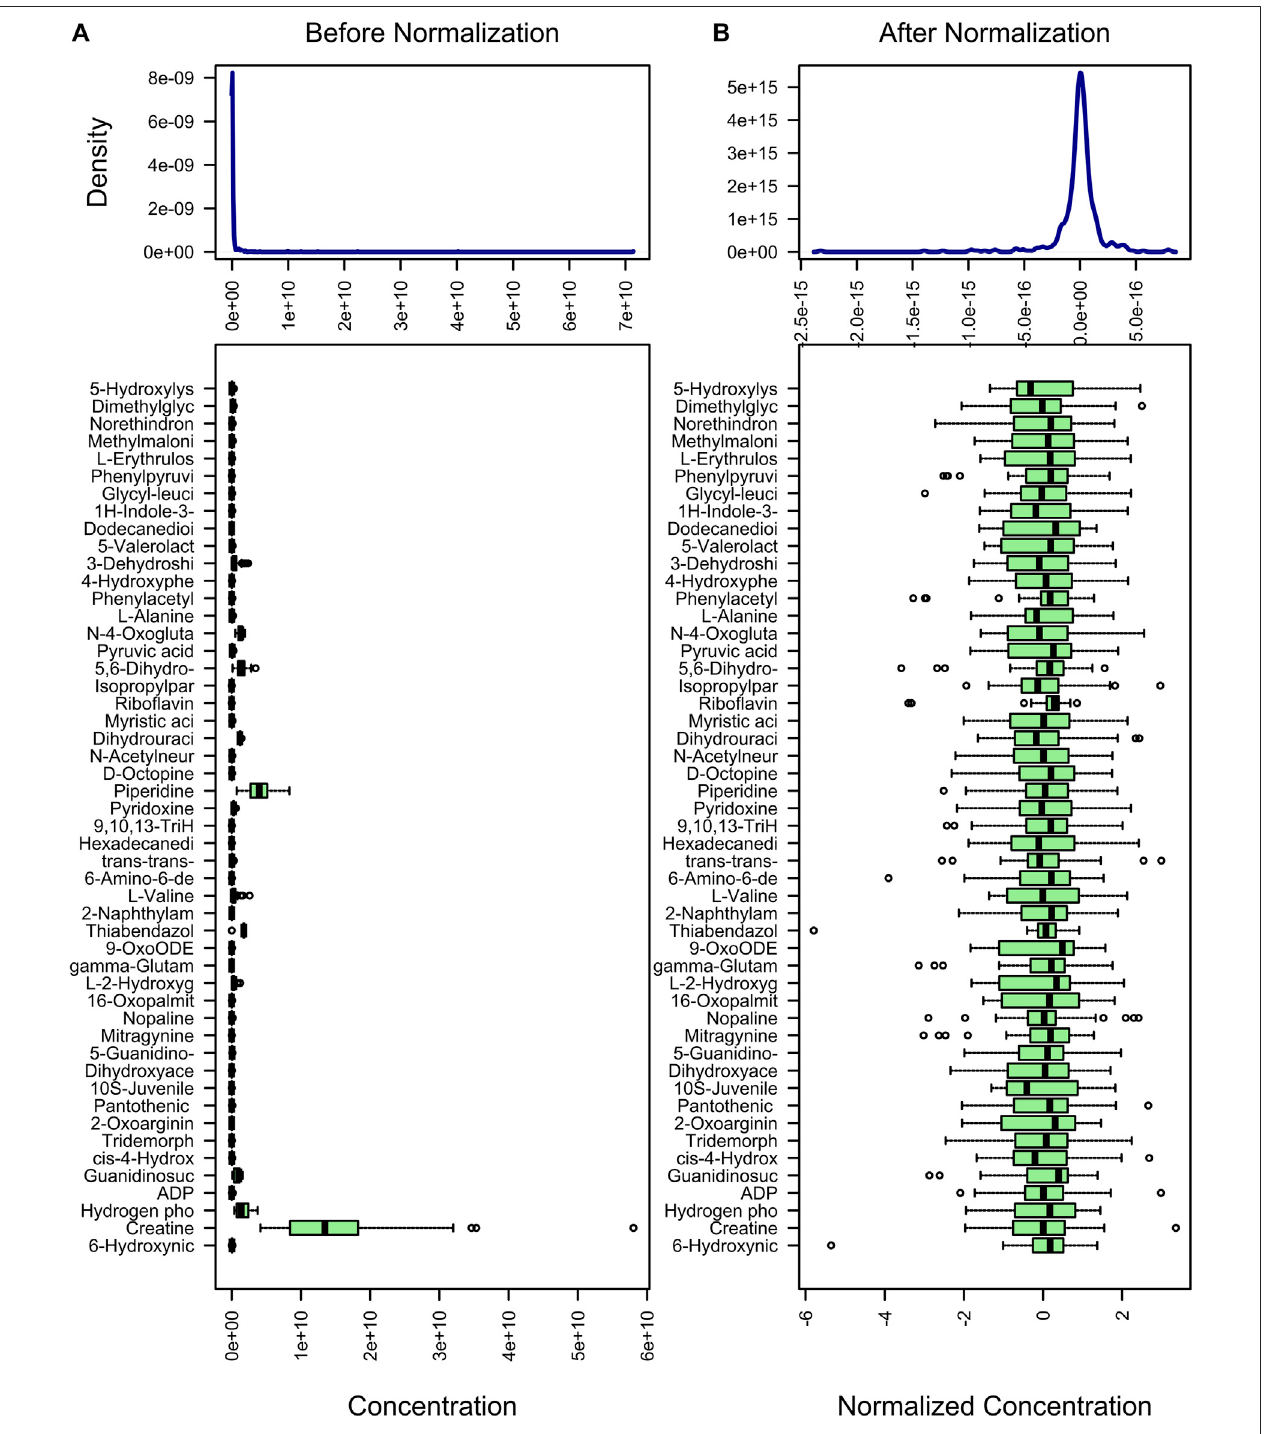
FIGURE 2 | Standardization of metabolites. The content distribution is represented by a box plot, which corresponds to outliers, minimum, lower quartile, median, upper quartile, maximum, and outliers from left to right. The picture on the left is the distribution before normalization, and the picture on the right is the distribution after